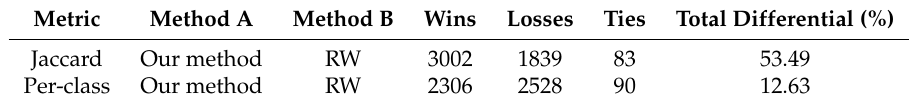
Table 7. Dataset 2 [5]: pairwise comparison of